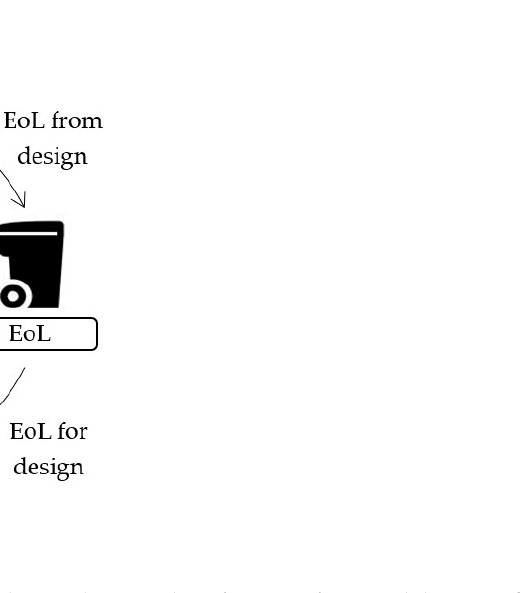
Figure 2. Approaches and possible exchanges between beneficiaries of EoL and designers [74].